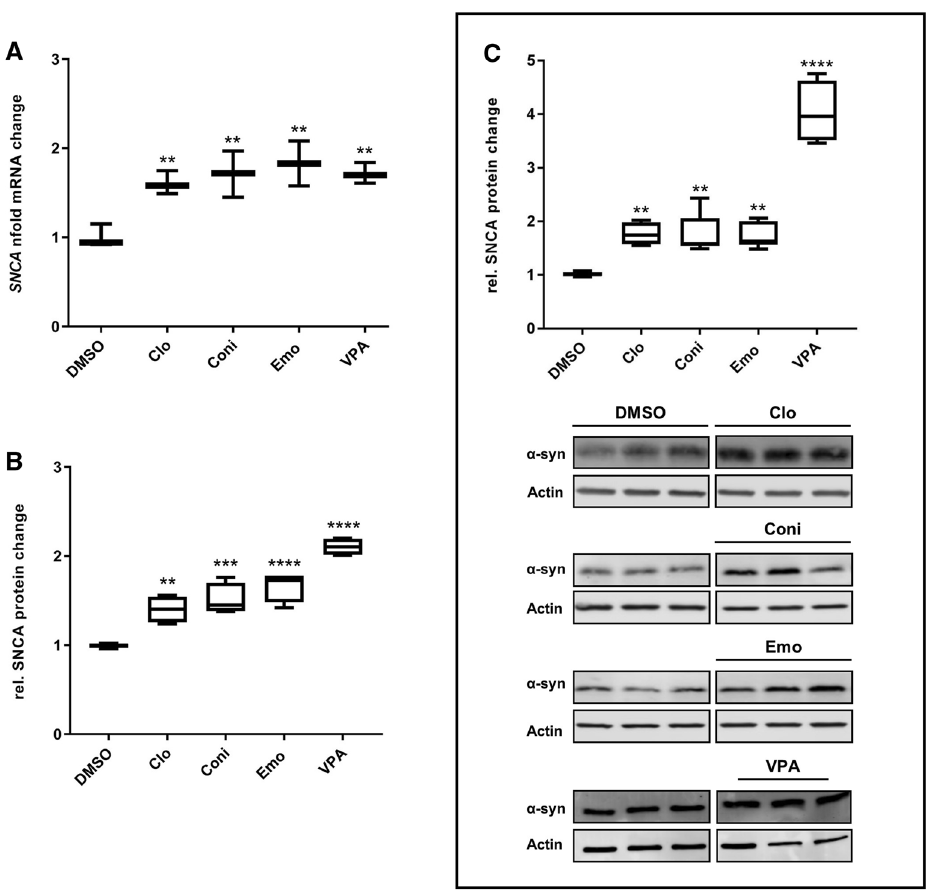
Figure 4. Compound treatment increased α-syn mRNA and protein levels in SH-SY5Y wildtype cells. ( A ) Expression fold change of SNCA mRNA measured with RT-qPCR. ( B ) Protein levels were determined by ICW and ( C ) WB in SH-SY5Y wild type cells. RT-qPCR data were normalized to three housekeeping genes and DMSO control, in triplicates, respectively. The Boxplot diagrams for ( B ) ICW represent the normalized mean of four 96-well plates with six to seven repetitions per compound, respectively. ( C ) For WBs six (VPA n = four) repetitions were conducted. Boxplot diagrams represent 5–95 percentile. ( C , lower) Representative WB. Compounds were applied at a final concentration of 25 µM (Clo 12.5 µM) for 24 h. VPA was used as a positive control at a concentration of 600 µM. *p < 0.1 **p < 0.01, ***p < 0.001, ****p = 0.0001. Full-size WB of DMSO and Clo see Supplementary Fig. S4A, DMSO and Coni see Supplementary Fig. S4B, DMSO and Emo see Supplementary Fig. S4C and DMSO and VPA see Supplementary Fig. S4D. ICWs ( B ) and WB ( C ) membranes were imaged with the LI-COR Odysseys Clx (Model 9140; S/N CLX-0554) and signals were quantified using the Image Studio software